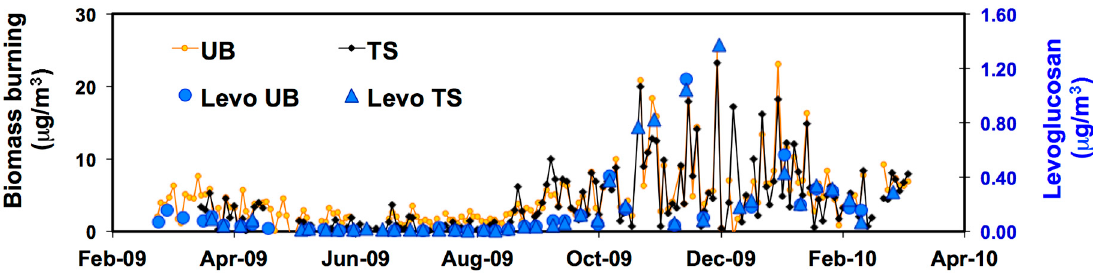
Figure 7. Daily concentrations of the Levoglucosan and of the biomass burning source in the urban background (UB) and traffic site (TS).